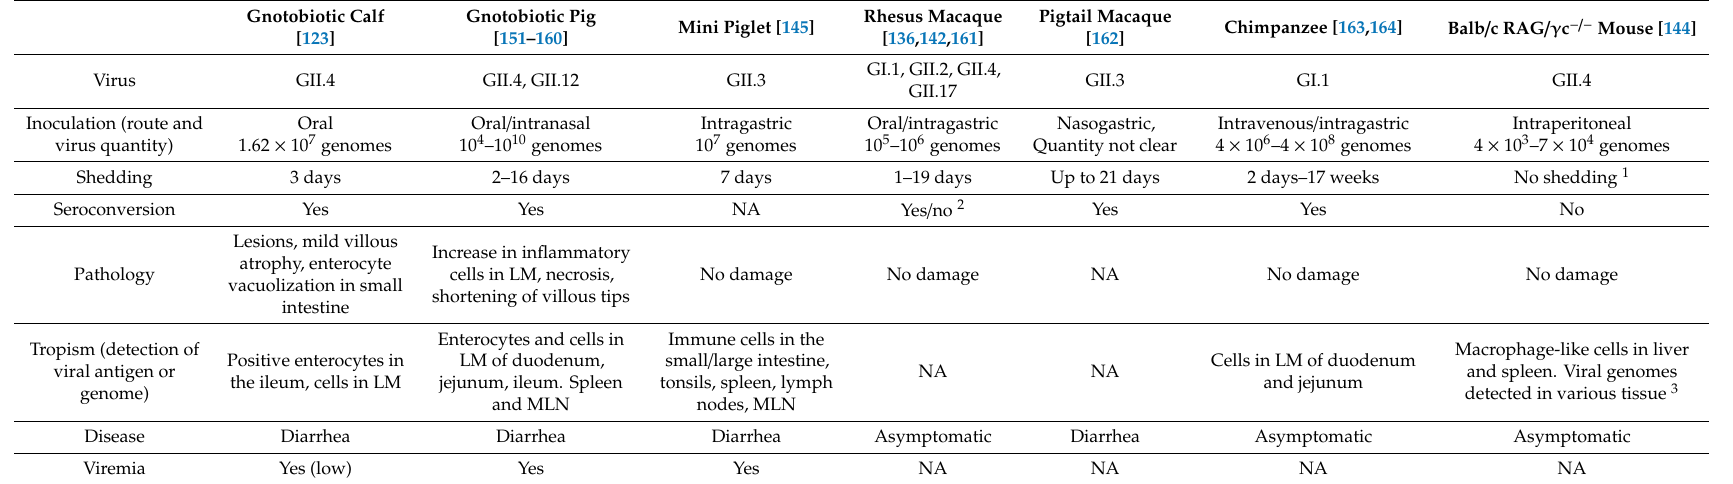
Table 2. Summary of animal models for human